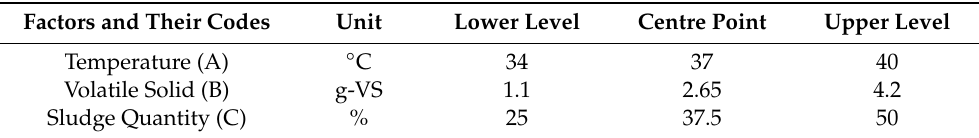
Table 1. Variable matrix and levels in actual